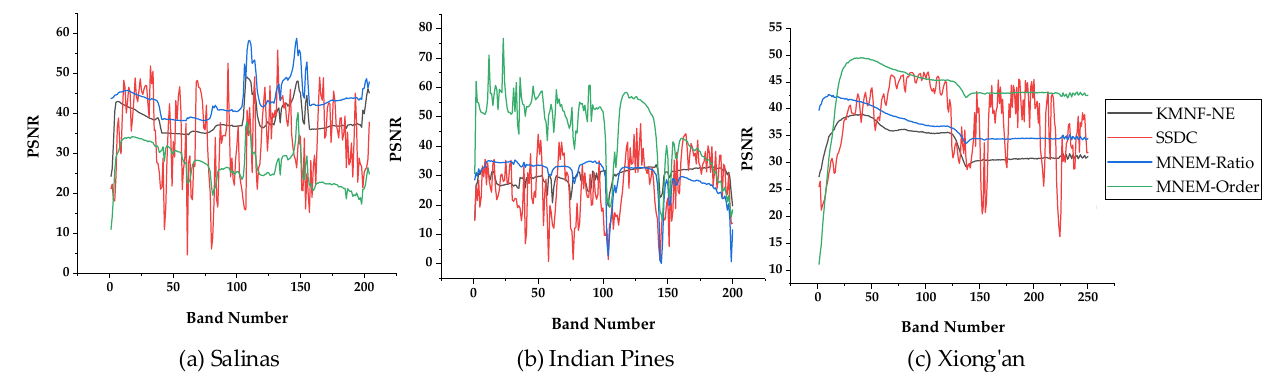
Figure 15. The peak signal-to-noise ratio (PSNR) of each band on the ( a ) Salinas, ( b ) Indian Pines, and ( c ) Xiong’an datasets.